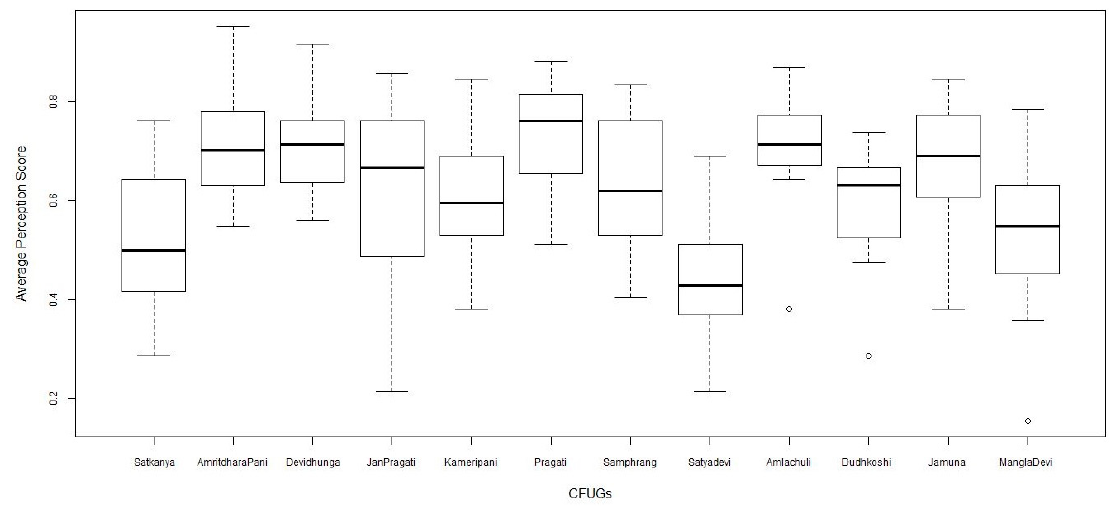
Figure 2. Boxplot for averaged perception score across twelve CFUGs. Table 4. Average standardized score of overall perception of forest users across 12 Users’ groups.